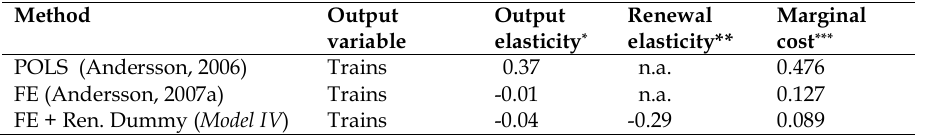
Table 7. Infrastructure operation costs - main